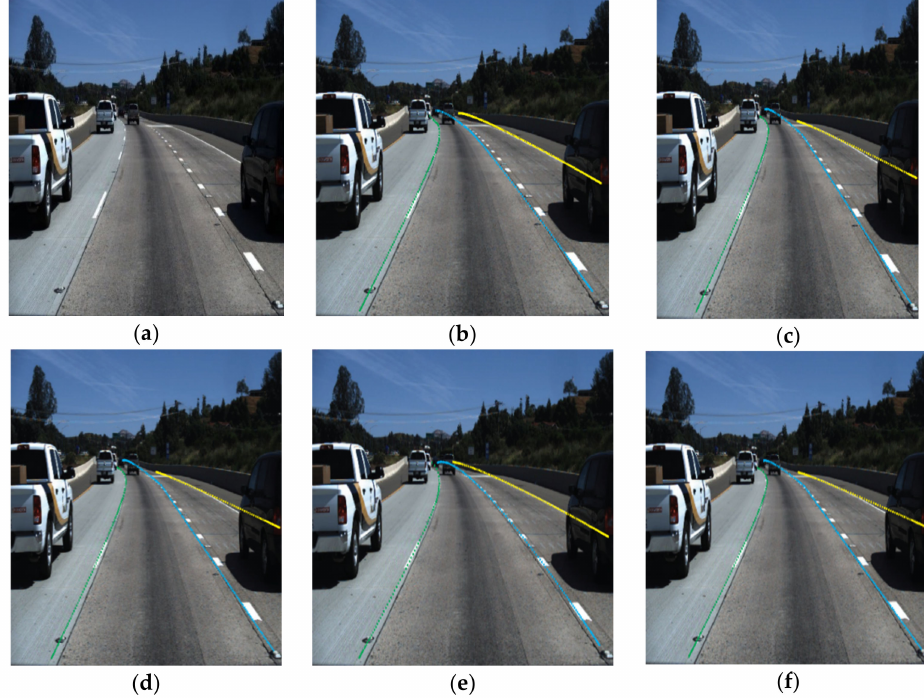
Figure 14. Predicted lane marking using DNN ( a ) Input ( b ) Lanenet ( c ) SCNN ( d ) CNN-LSTM ( e ) ERFNet-DLSF and ( f )